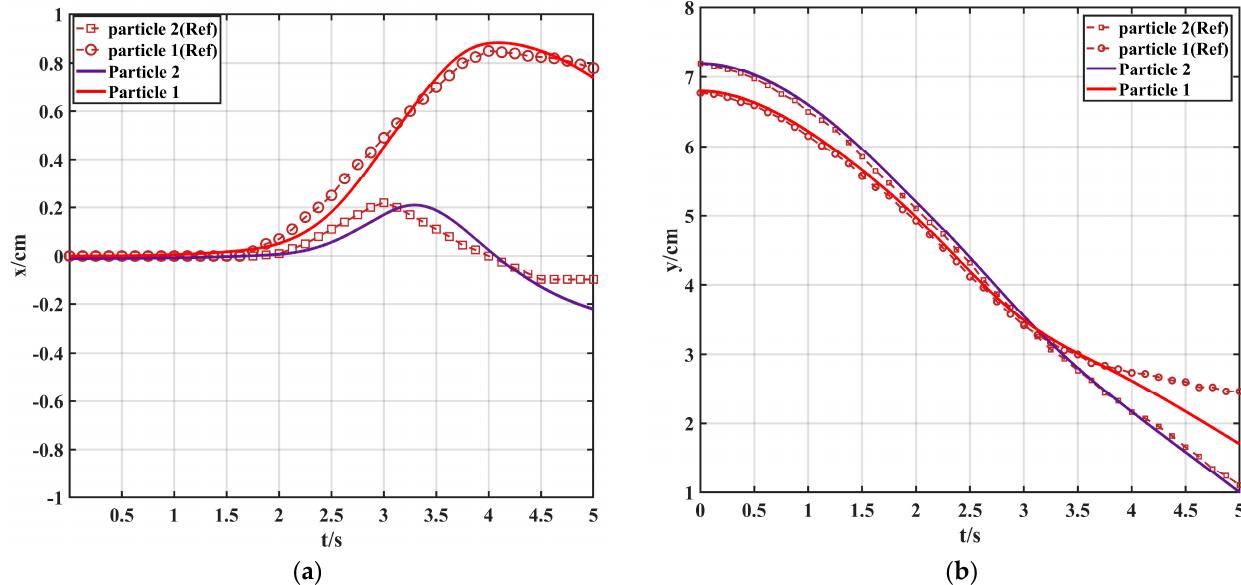
Figure 7. The motion trajectory compared with paper [16]: ( a ) motion trajectory on X-axis with time t (s); ( b ) motion trajectory on Y-axis with time t (s). Figure 8 is the overall trajectory of the particles accompanied by the change in